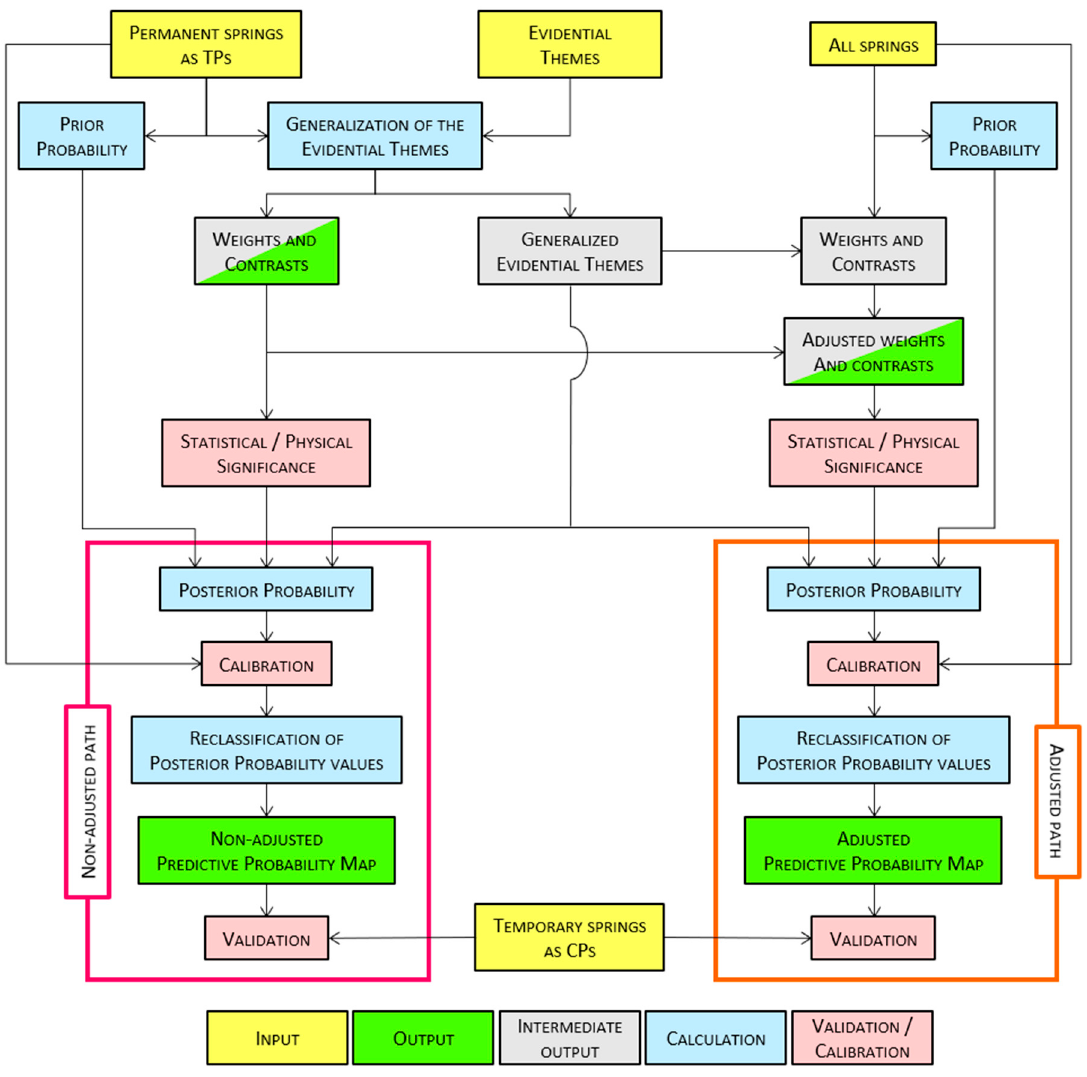
Figure 1. Workflow for answering Q2.